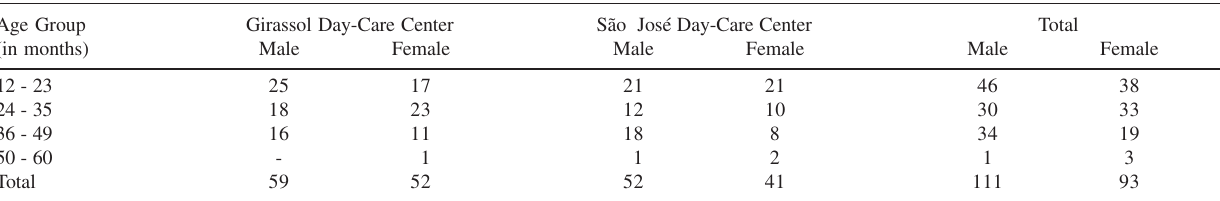
Table 1 - Distribution of 204 children included in the study according to gender and age. São Paulo Municipality, August 2003 to September